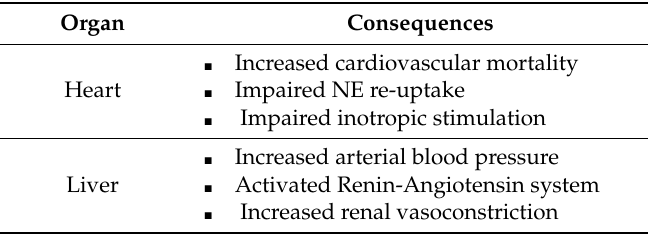
Table 2. Activated sympathetic nerve in other organs. Organ